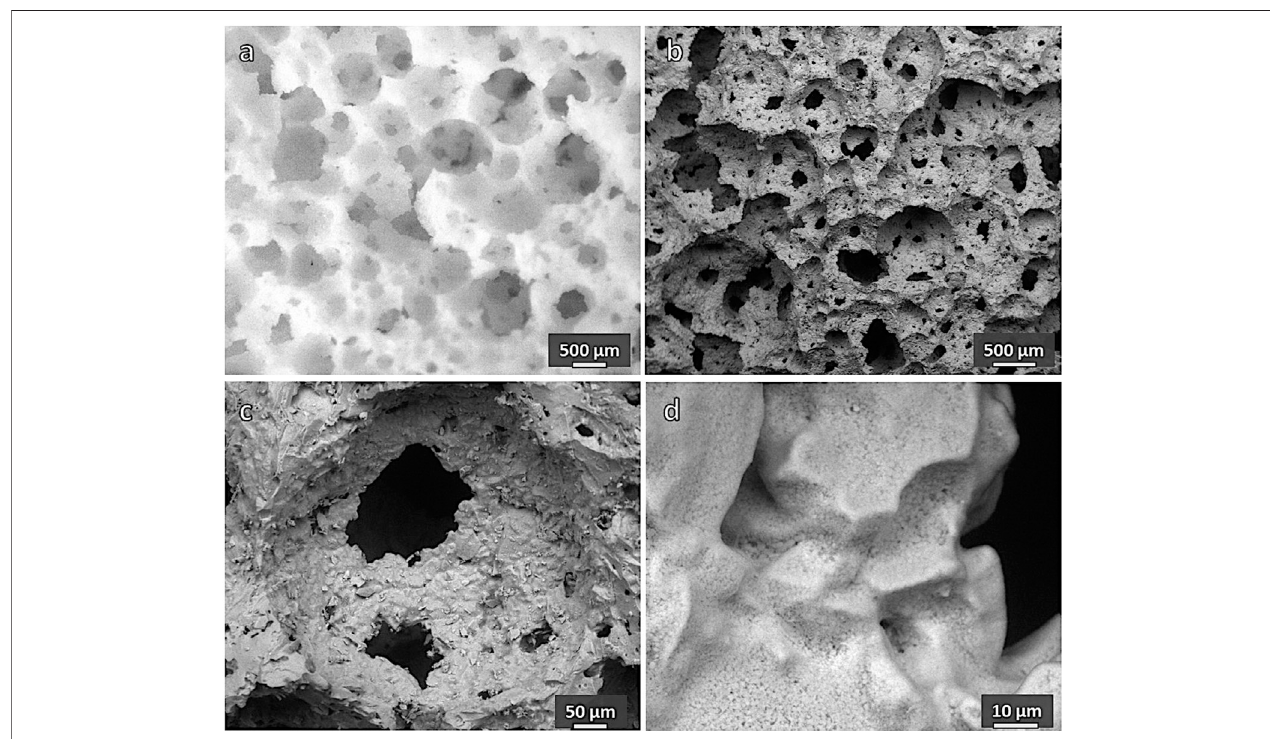
FIGURE 7 | Microstructural details of a porous glass-ceramic from remelted Biosilicate ® (sample [C], 60 wt% solid loading, 0 h): (A) green foam; (B – D ) foam after fi ring at 1,000 ° C for 1 h.